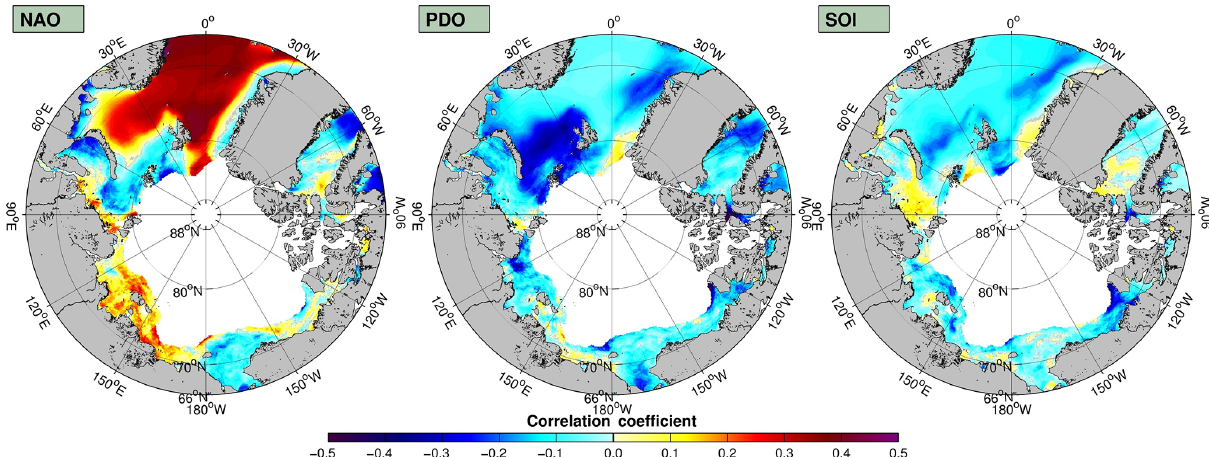
Figure D1. Correlation coefficients calculated from monthly time series of H s of CFSR and the North Atlantic Oscillation (left) and Pacific Decadal Oscillation